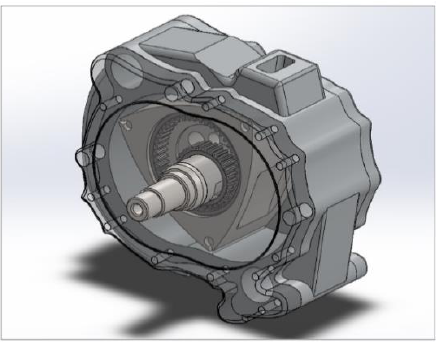
Figure 2. The CAD model of the Wankel Engine.